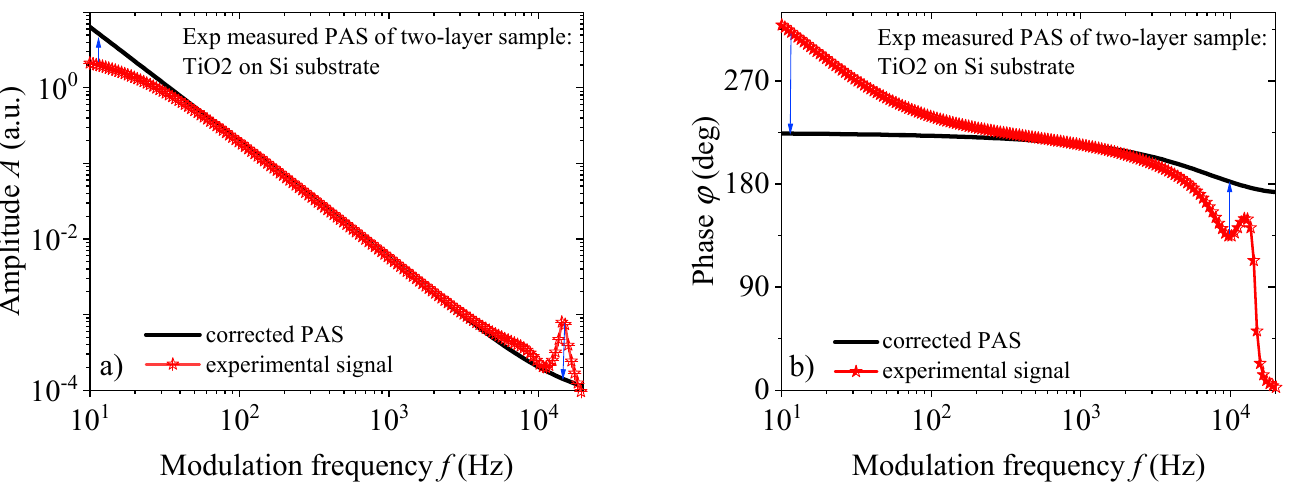
Figure 1. Open-cell experimental set-up in transmission configuration.